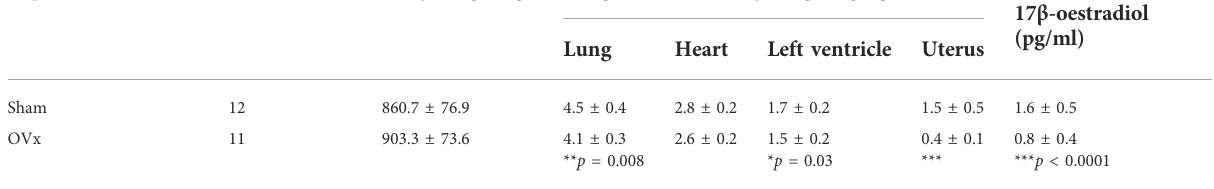
TABLE 1 Weight ratios and blood serum concentrations of 17 β -oestradiol from sham and OVx. Experimental